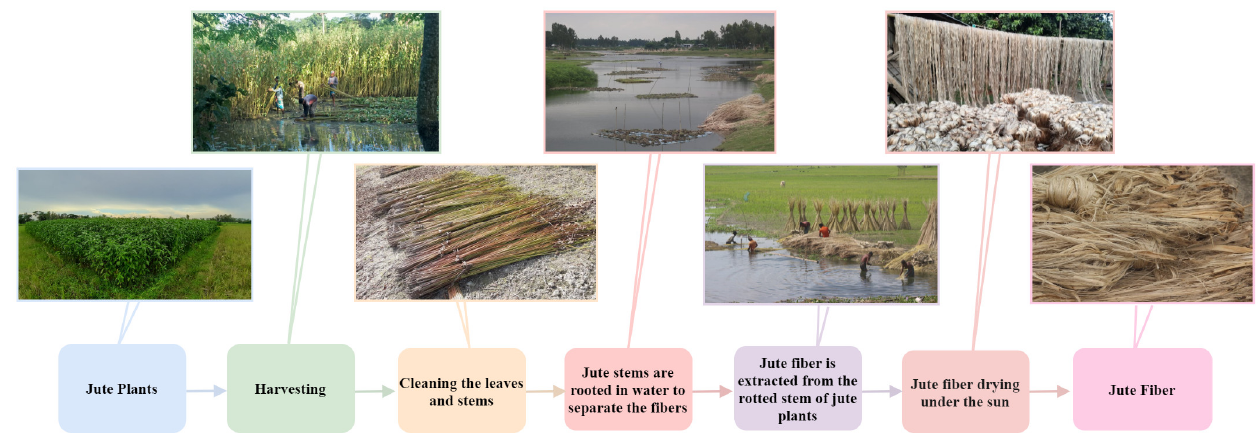
Figure 1. Demonstration of the full process of jute manufacturing. The production process comprises at least six steps, starting from harvesting to the binding of jute fiber.